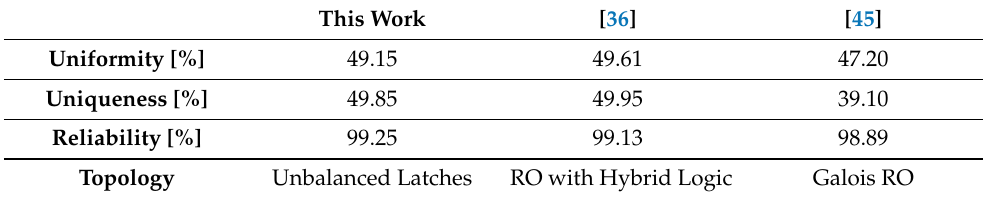
Table 1. Summary and comparison of the PUF quality. This